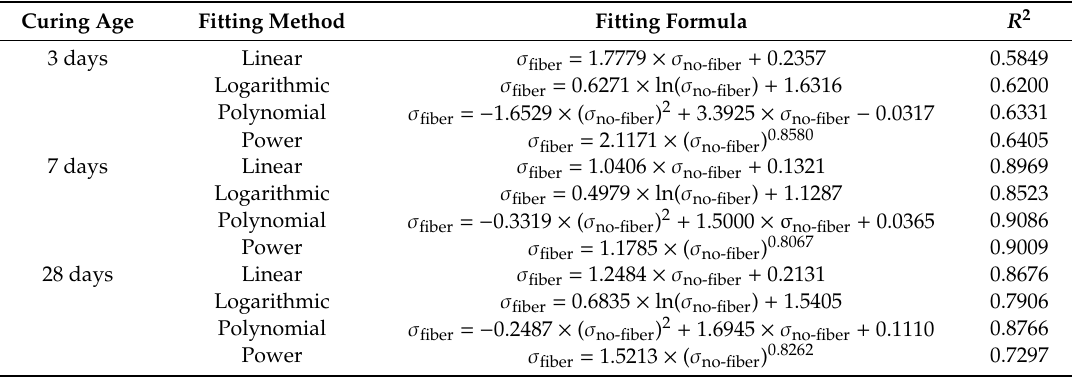
Figure 7. The fitting curves of UCS fiber-reinforced as a function of UCS unreinforced with di ff erent curing times: ( a ) 3 days curing time; ( b ) 7 days curing time; ( c ) 28 days curing time. Table 4. Fitting methods, fitting formulas and R 2